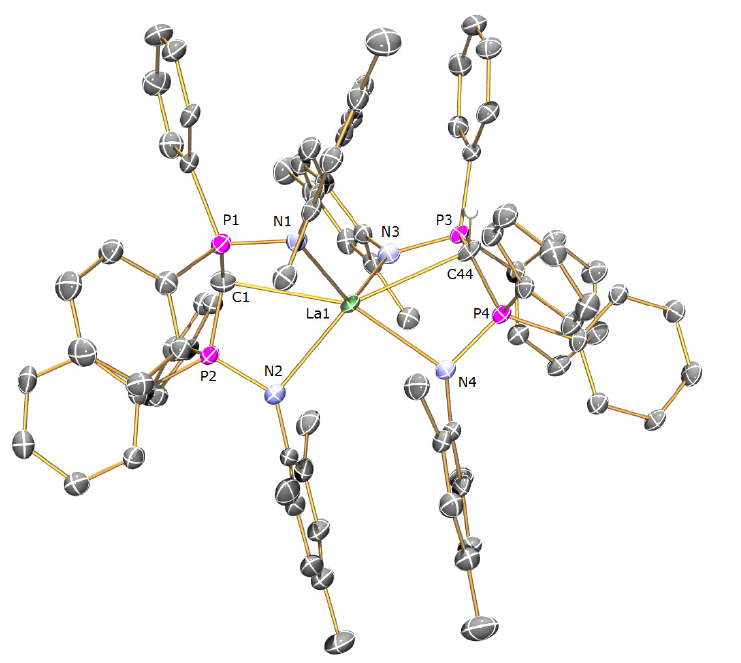
Figure 8. Molecular structure of 7a 3C ellipsoids are drawn at 50% probability, with lattice solvent and non-methanide hydrogen atoms omitted for clarity. The molecular structures of 7 b–d are very